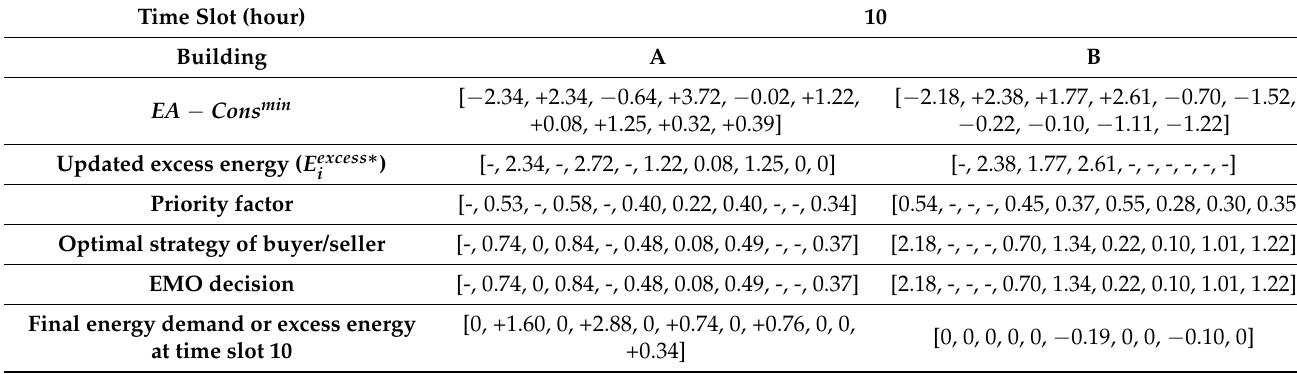
Table 2. The energy trading step in Buildings A and B at time slot